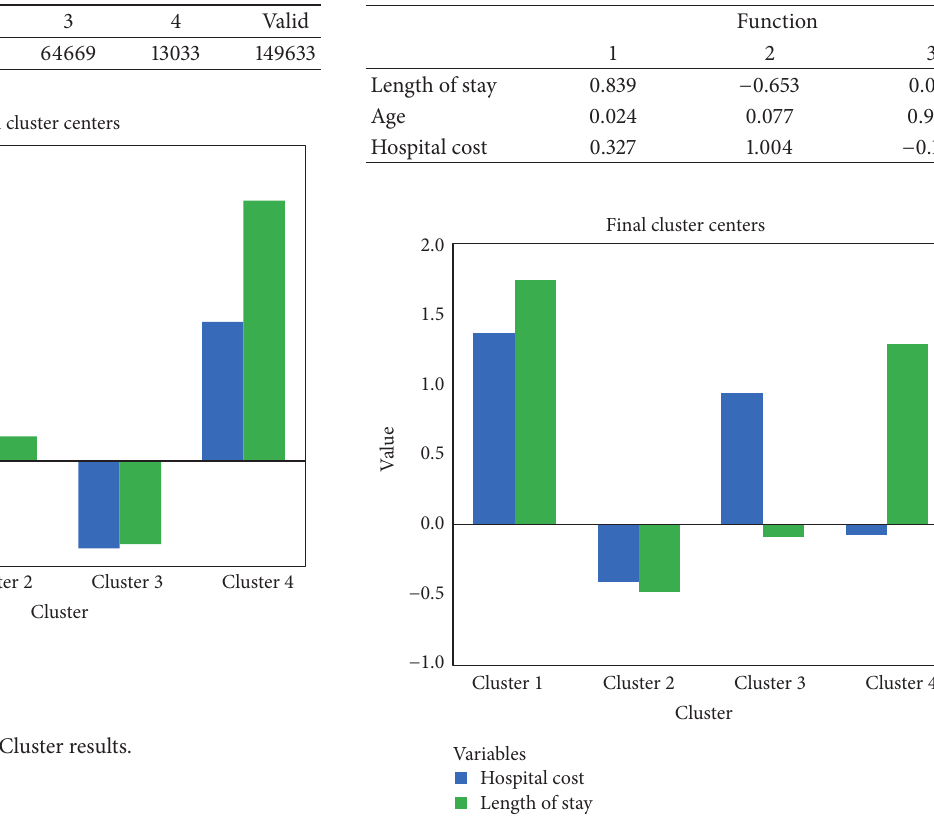
Table 2: Number of cases in each cluster.